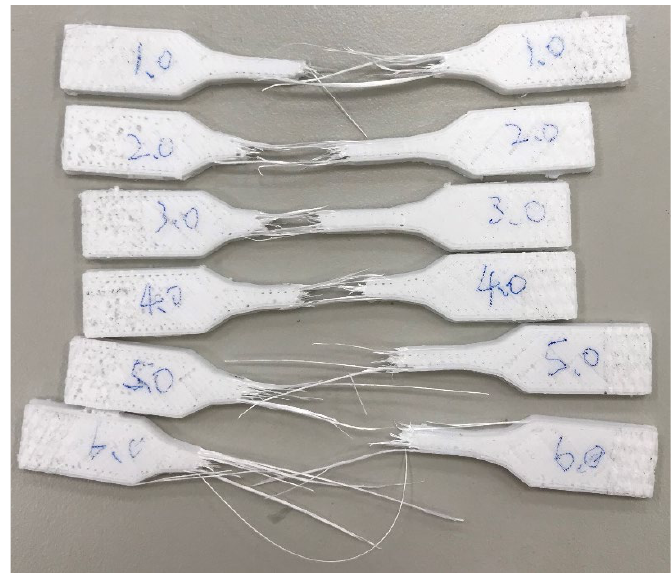
Figure 2. Breakage of the tensile specimens.